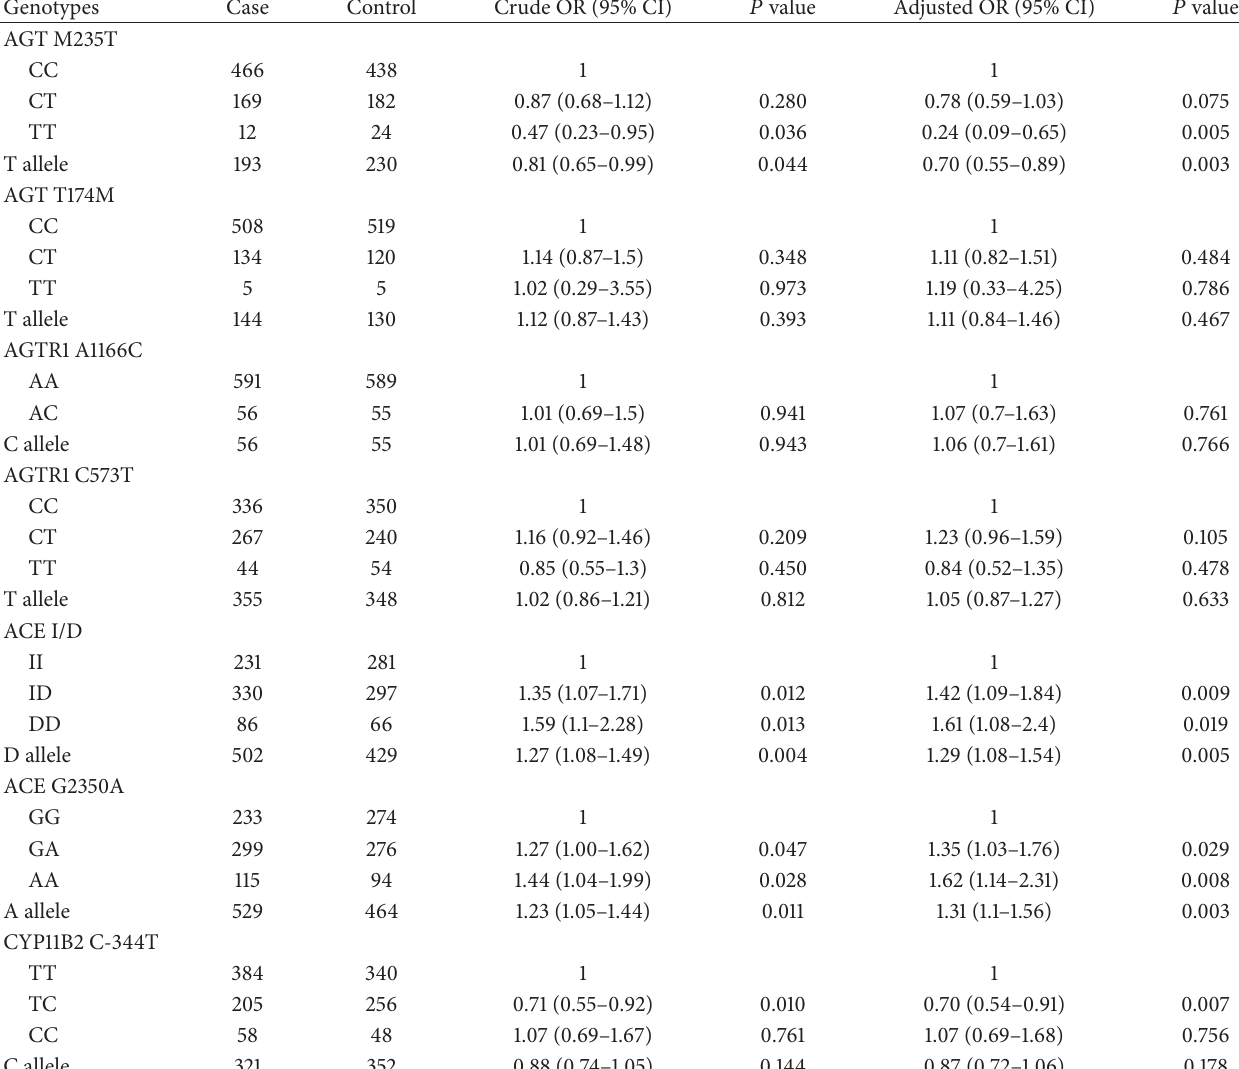
Table 2: Genotype distribution of the RAAS polymorphisms among ESRD patients and